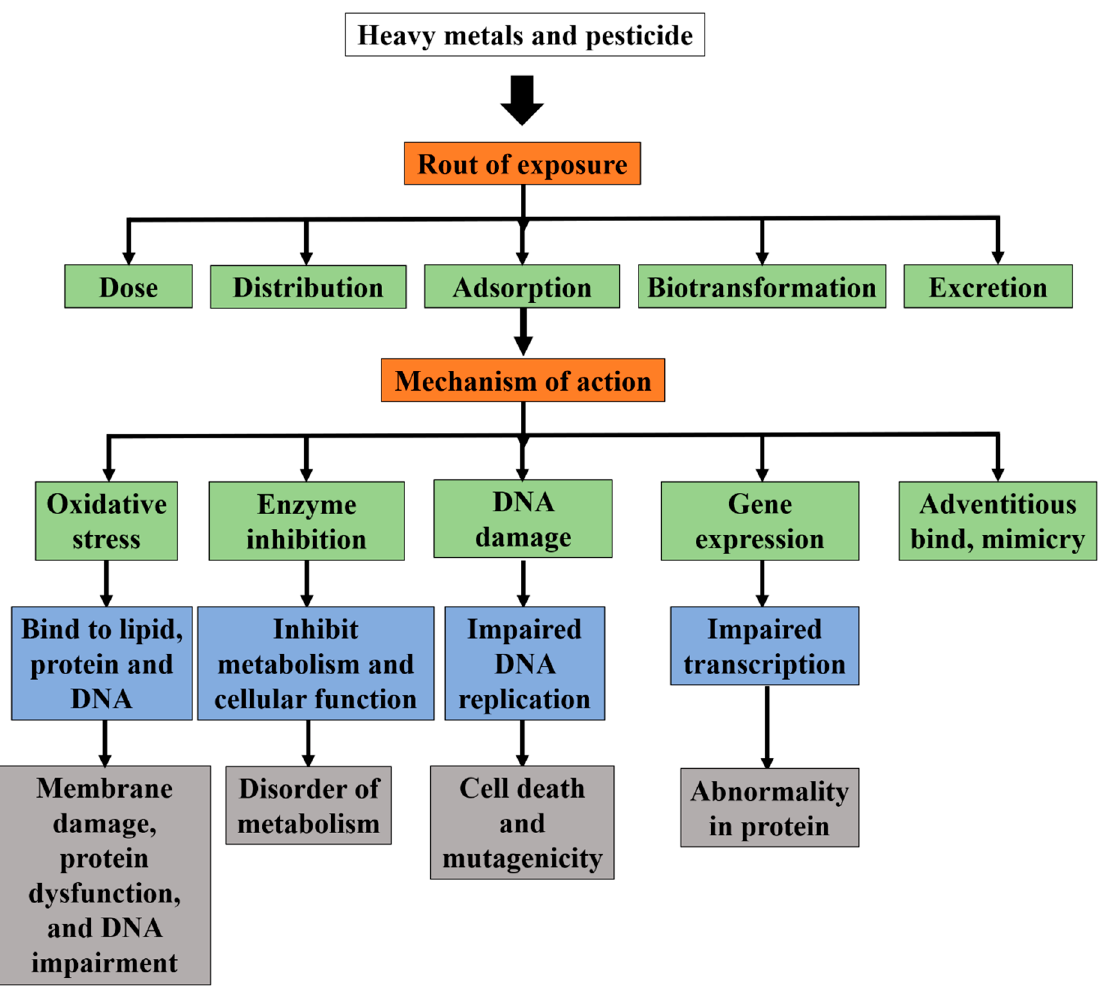
Figure 1. Common route of absorption, distribution, and excretion related to the exposure of HMs and inorganic pesticides. Adapted from [29], with permission from Frontiers, 2017.